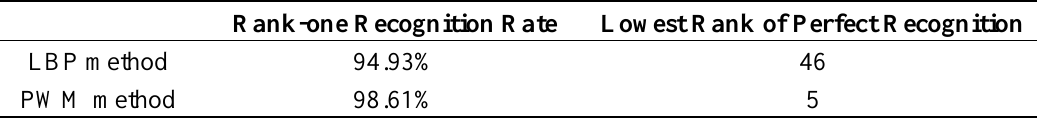
Table 3. Identification performance by different methods.